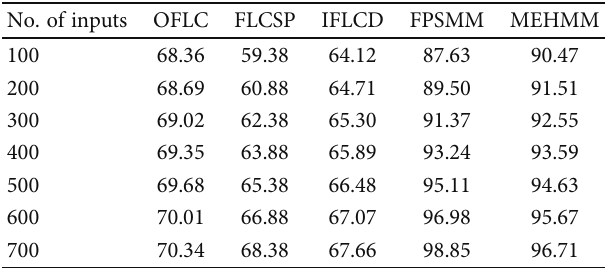
Table 5: Sensitivity to high temperature.